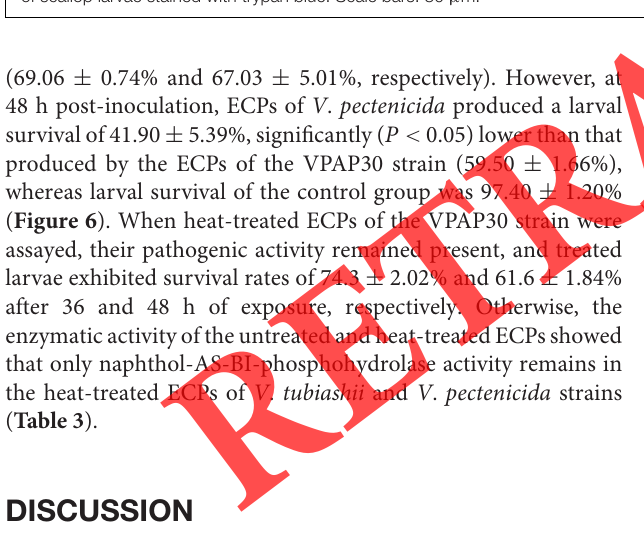
FIGURE 4 | Main clinical signs exhibited by Argopecten purpuratus larvae infected with V. tubiashii VPAP30 after 24 h of exposure. (A) Bacterial swarms of bacteria on the margins of the larvae, (B) velum disruption, (C) detachment of ciliary cells of the velum (black arrows), and (D) necrosis of digestive tissue of scallop larvae stained with trypan blue. Scale bars: 30 µ